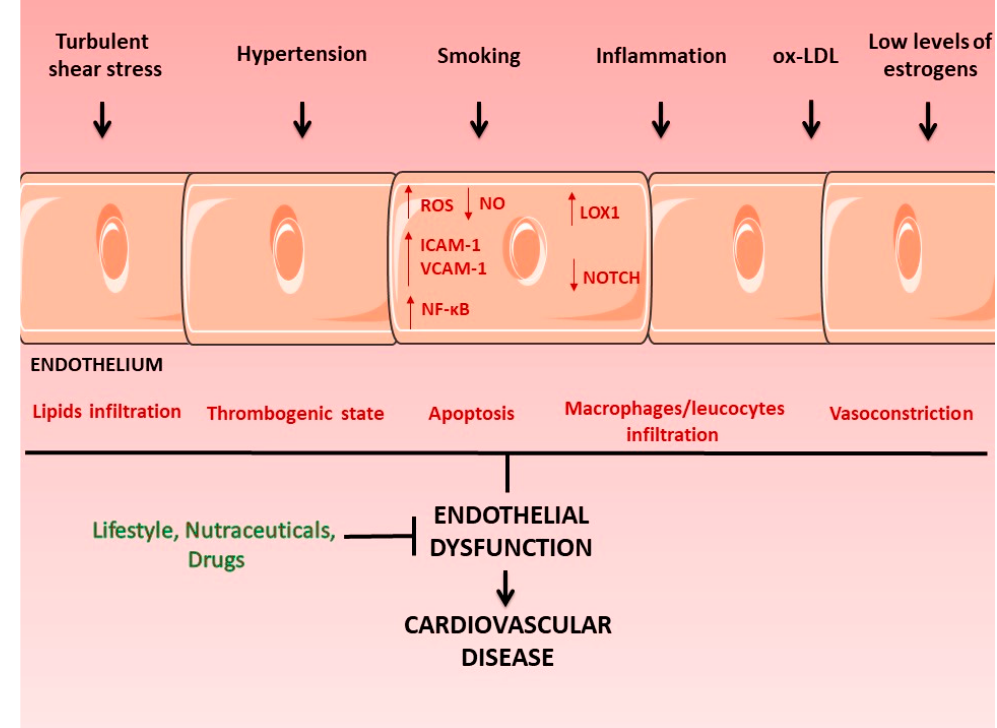
Figure 1. Endothelial dysfunction and cardiovascular diseases (CVDs) . Damage to the endothe- lium caused by different stimuli, including turbulent shear stress, hypertension, smoking, exposure to proinflammatory mediators, ox-LDL, and low levels of estrogens, leads to alterations in endothelial cells, such as increased production of ROS, reduced bioavailability of NO, overexpression of ICAM-1 and VCAM-1, and alteration of molecular pathways involved in endothelial dysfunction (including LOX-1, NF- κ B and Notch pathway). The mechanical and biological conditions cited above cause the loss of endothelium integrity, leading to vasoconstriction, lipids, macrophages, and leukocyte infiltration in the subendothelial space, thrombogenicity, and apoptosis of endothelial cells, creating the conditions for the formation of atherosclerotic plaques, the main cause of cardiovascular disease. ox-LDL = oxidized low-density lipoproteins; ROS = reactive oxygen species; ICAM = intercellular adhesion molecule; VCAM = vascular cell adhesion molecule; NF- κ B = nuclear factor kappa-light-chain-enhancer of activated B cells; LOX1 = lectin- like oxidized low-density lipoprotein receptor 1, NO = nitric